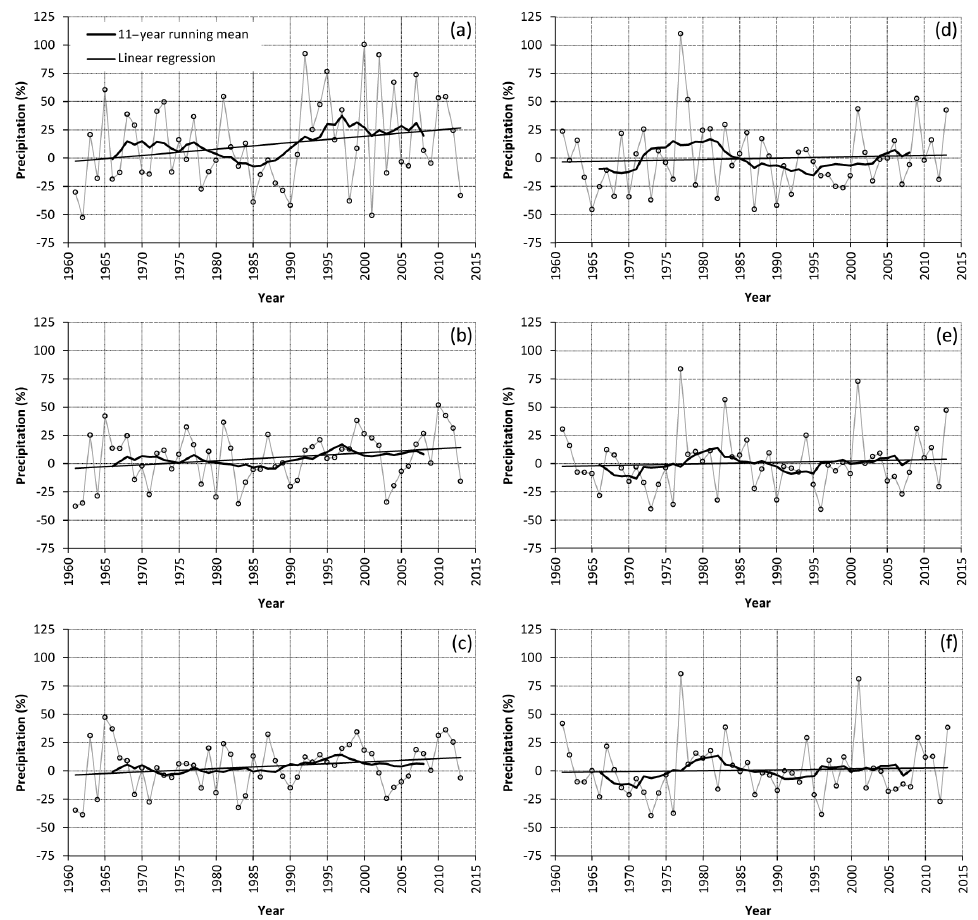
Figure 7. Left column: ablation season (Jun–Sep) total precipitation anomalies in (a) Gran Paradiso, (b) Ortles-Cevedale and (c) Val Ridanna. Right column: accumulation season (Oct–May) total precipitation anomalies in (d) Gran Paradiso, (e) Ortles-Cevedale and (f) Val Ridanna. Reference period: 1961–1990. None of the linear trends is significant at the 0.05 level.